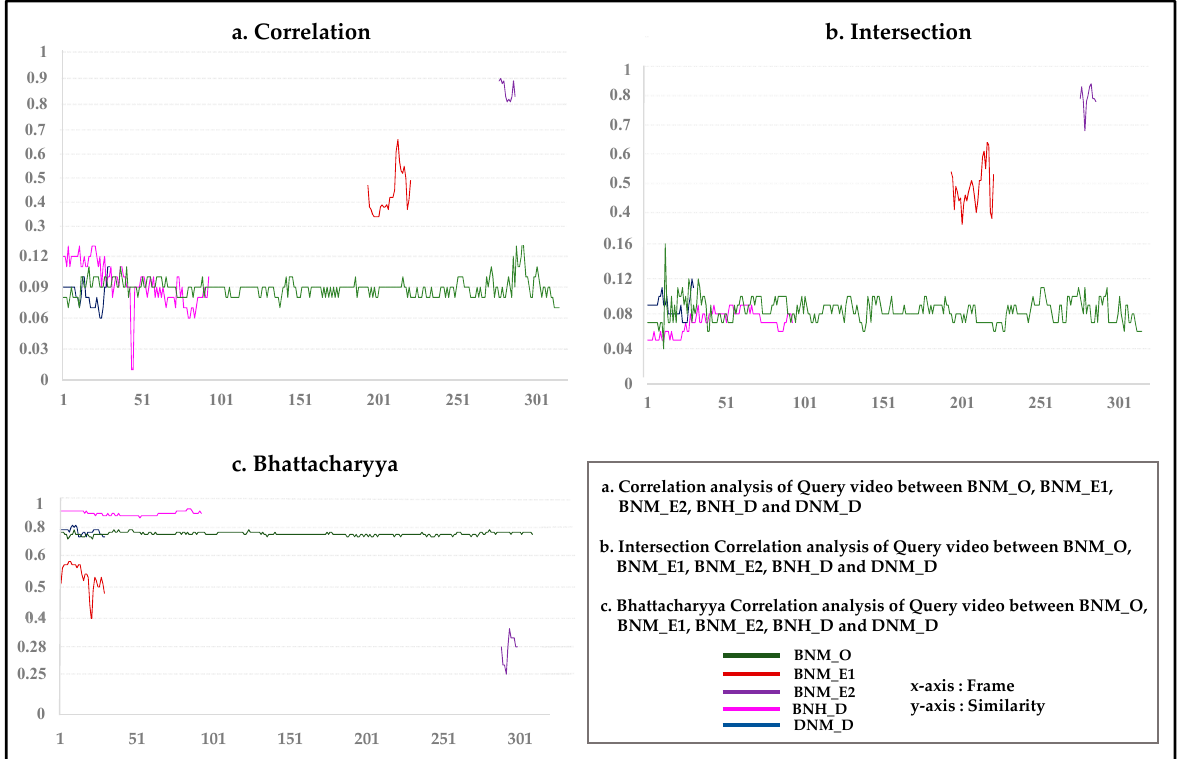
Figure 8. Algorithm similarity comparisons between query video and other videos (scenario 1).